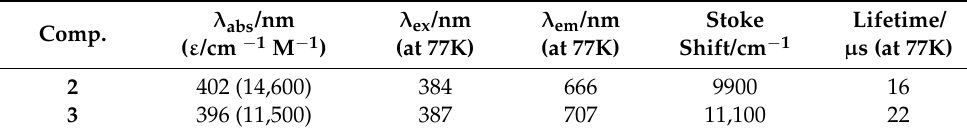
Table 2. Photophysical data of 2 and 3